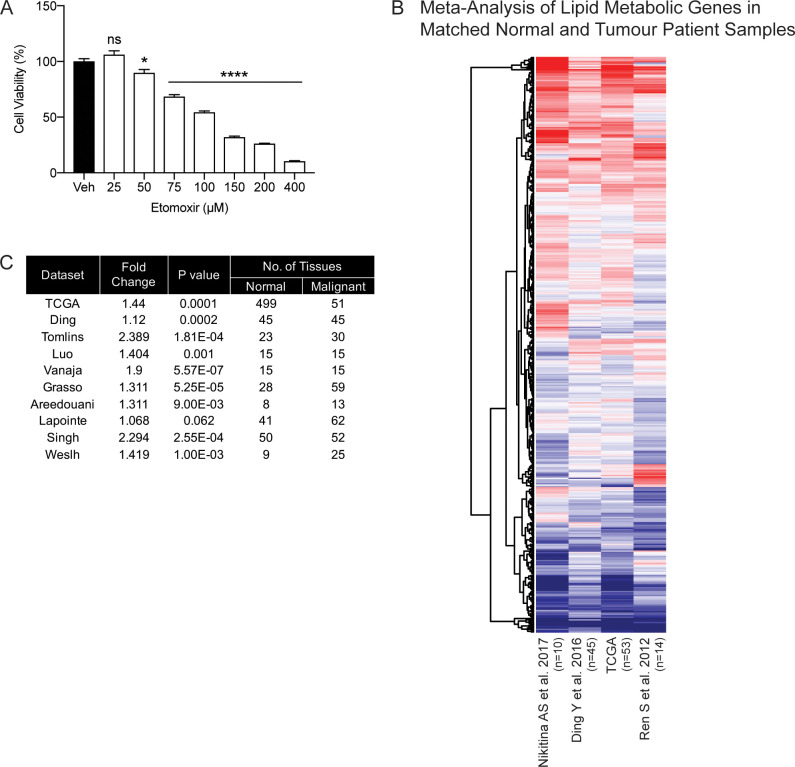
Fatty acid metabolism is consistently altered in clinical prostate tumors.(A) Cell viability of LNCaP cells treated with indicated concentrations of etomoxir for 72 hr. Cell viability was determined using CyQUANT Cell Assay. (B) A meta-analysis of 735 lipid metabolism genes using four clinical datasets with malignant and matched normal RNA-sequencing data (n = 122). Genes were rank-ordered on the basis of their meta effect size scores in PCa malignant tissues versus matched normal. (C) Fold change of DECR1 mRNA expression in malignant tissues compared to benign/normal tissues. Data were obtained from Oncomine.